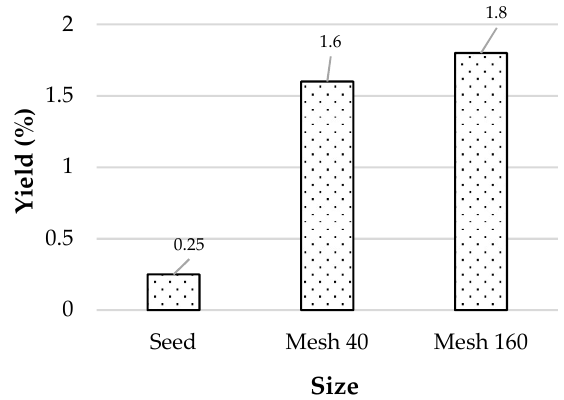
Figure 3. The influence of material size on the yield of essential oil.